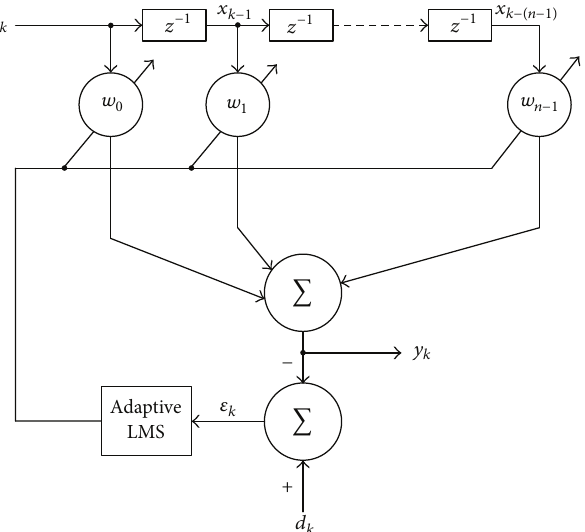
Figure 4: Block diagram of finite impulse response